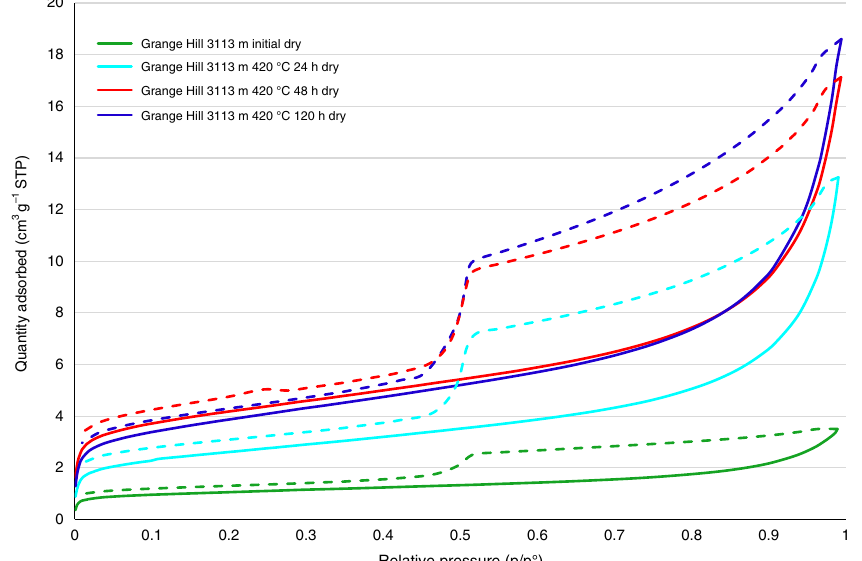
Fig. 4 N 2 sorption isotherms for dry initial and matured Grange Hill shale samples from sequential HPWP pyrolysis (solid lines are for adsorption and dotted lines for